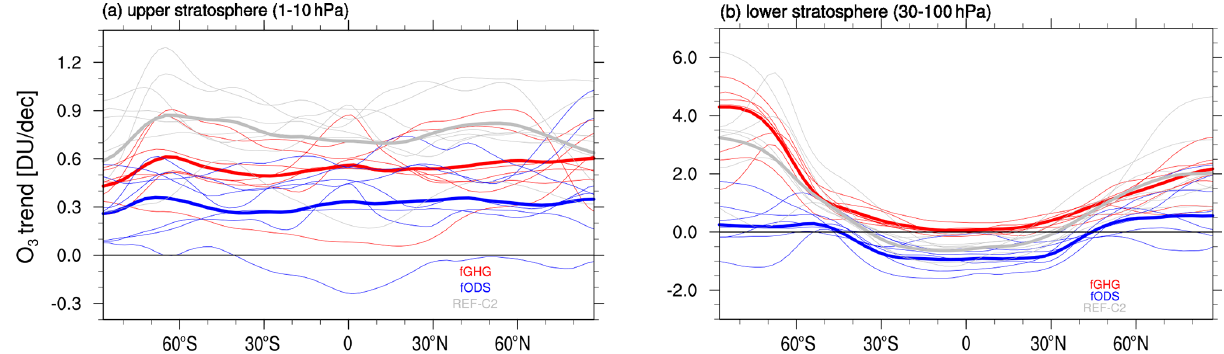
Figure 9. Latitudinal distribution of ozone column trends over the period 1998–2040 for all REF-C2 (grey lines), fGHG (red lines), and fODS simulations (blue lines) for (a) the upper stratosphere (1–10hPa) and (b) the LS (30–100hPa). Thick lines indicate the MMM ozone